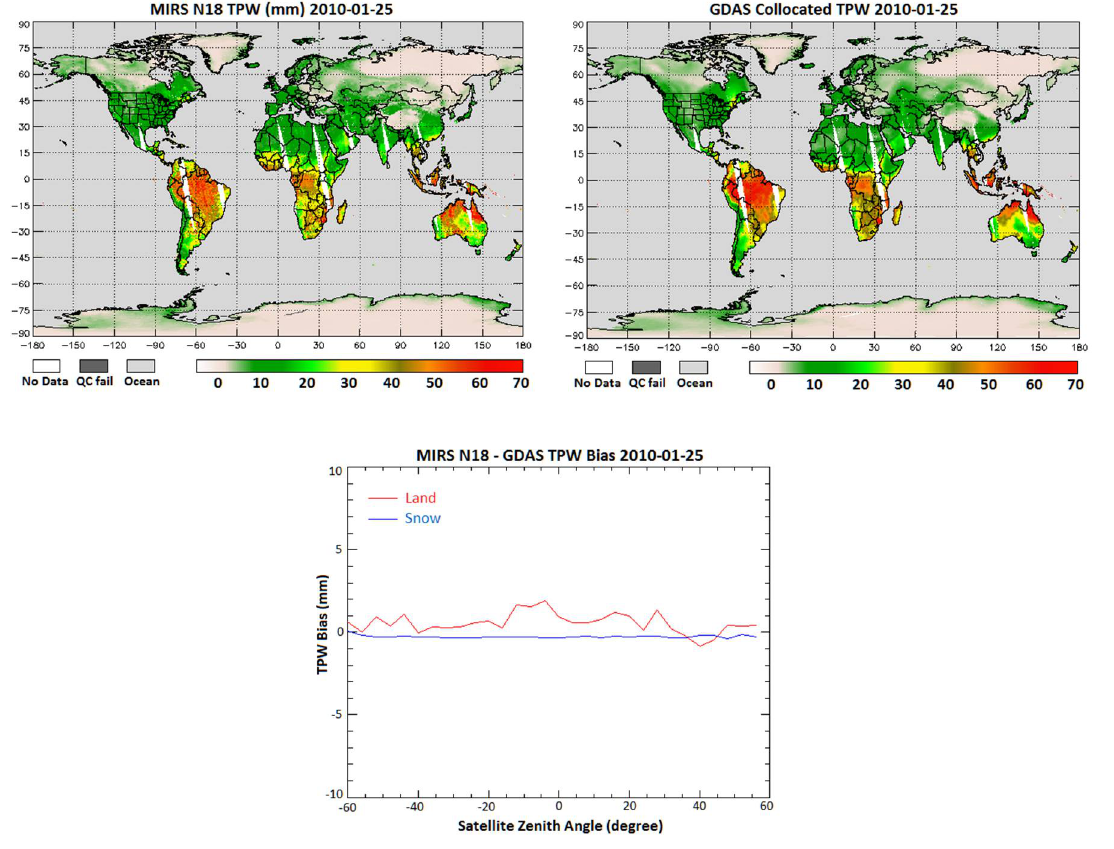
Figure 11. MiRS derived TPW ( top left ) and GDAS TPW ( top right ) for January 23, 2010. The TPW difference as a function of scan angle is shown for land and snow-free land surfaces ( bottom) .